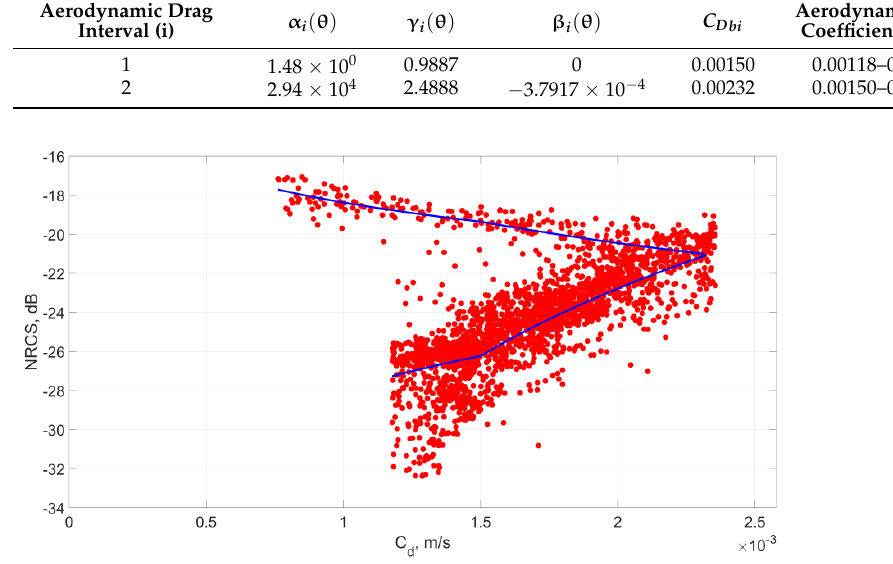
Figure 8. Dependencies of the NRCS on the drag coefficient for all sub swaths; the blue curve represents the proposed approximations. The number of points is equal to 269 (for the upper dependence) and 2235 (for the lower dependence).